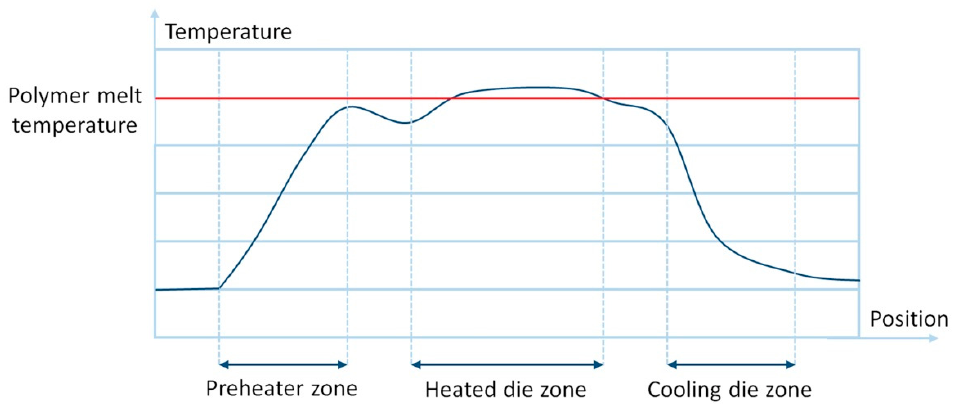
Figure 4. Typical distribution of temperatures inside the pultrusion